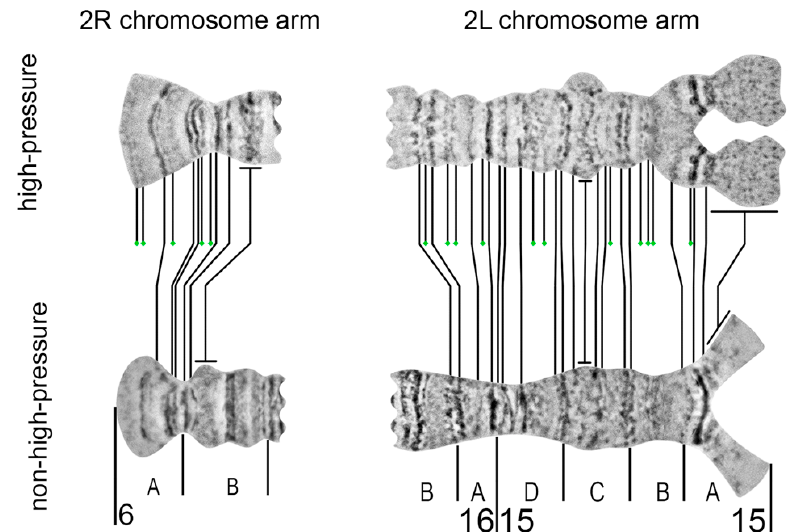
Figure 9. Comparison of the high-pressure ( top ) and non-high-pressure ( bottom ) maps for 6A–6B region in the 2R arm and 15A–16A in the 2L arm of nurse cell chromosomes of An. beklemishevi . The new bands in the high-pressure map are labeled by green circles.